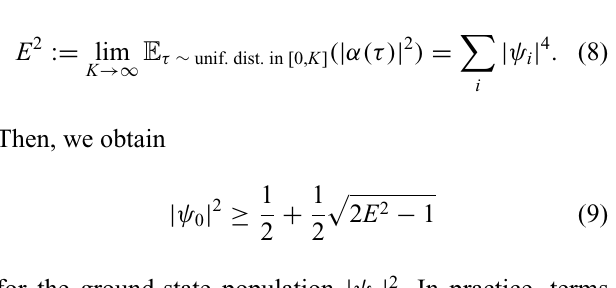
FIG. 3. The quantum circuit for unitary dynamics controlled by a single ancilla qubit in the |+(cid:2) state.